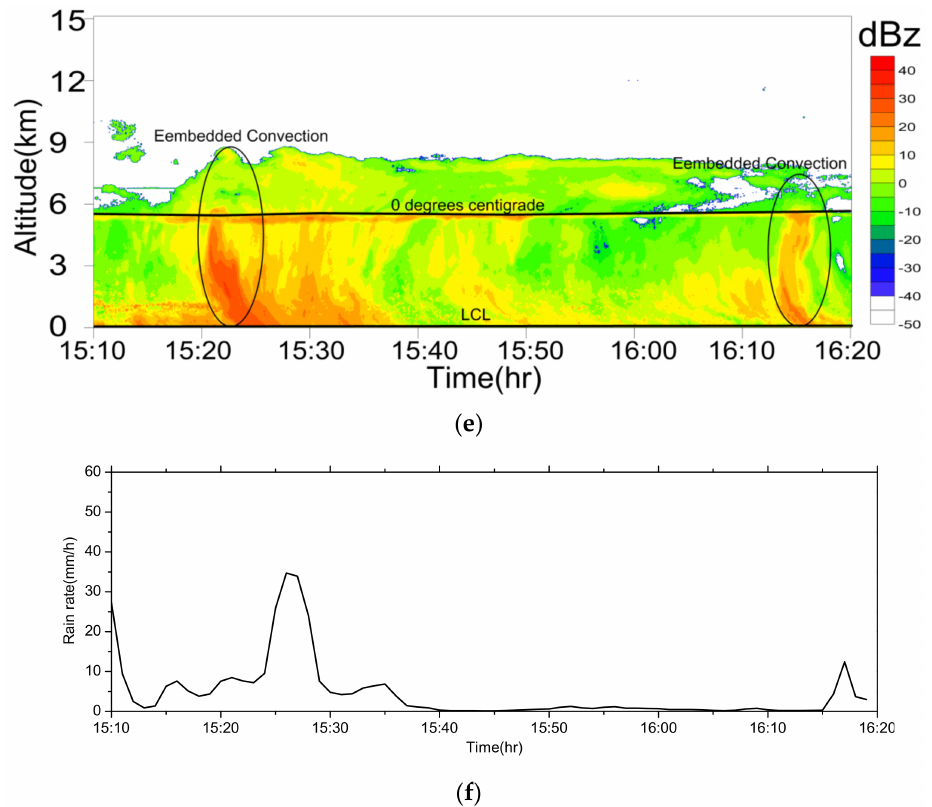
Figure 5. ( a ) The C-FMCW radar reflectivity on 22 June; ( b ) rain rate at the height of 100 m on 22 June detected by the MRR; ( c ) the C-FMCW radar reflectivity on 28 June; ( d ) same as ( b ), rain rate on 28 June; ( e ) the C-FMCW radar reflectivity on 11 July; ( f ) same as ( b ), rain rate on 11